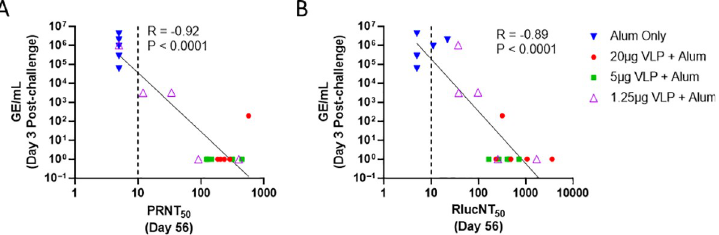
Fig 9. Correlate of protection by ZIKV VLP vaccine. Day 3 post-challenge ZIKV GE/mL (RNAemia) compared to day 56 nAb titers obtained by (9A) PRNT 50 and (9B) RlucNT 50 assays are plotted for each animal with immunization groups denoted by symbol. R and P values and regression lines are shown and non-Log transformed values plotted. The dashed line shows the LOD for the RlucNT 50 assay, and RNA GE/mL levels that were undetectable were assigned a value of 10 0